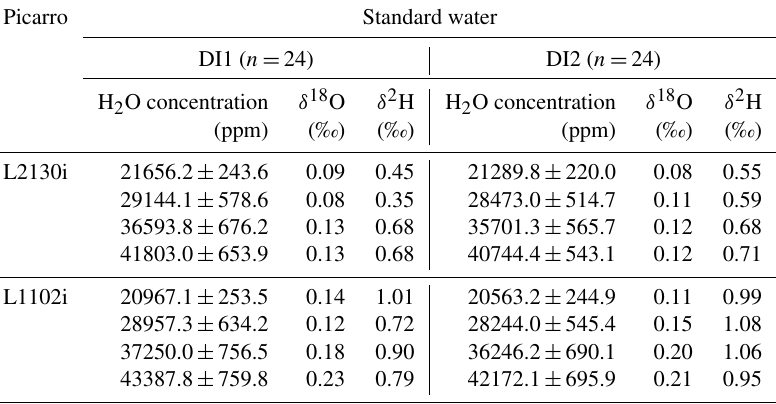
Table 1. Standard deviations of δ 18 O and δ 2 H at each concentration level from all 24 calibration runs for the respective DI1 and DI2 standard waters. The standard deviations were calculated from the whole data set of raw 7min average values, obtained by L2130i and L1102i on each calibration run. The mean values of H 2 O concentration at each concentration level were also calculated from all 24 data set of raw 7min average values, obtained by L2130i and L1102i on each calibration run. Picarro Standard